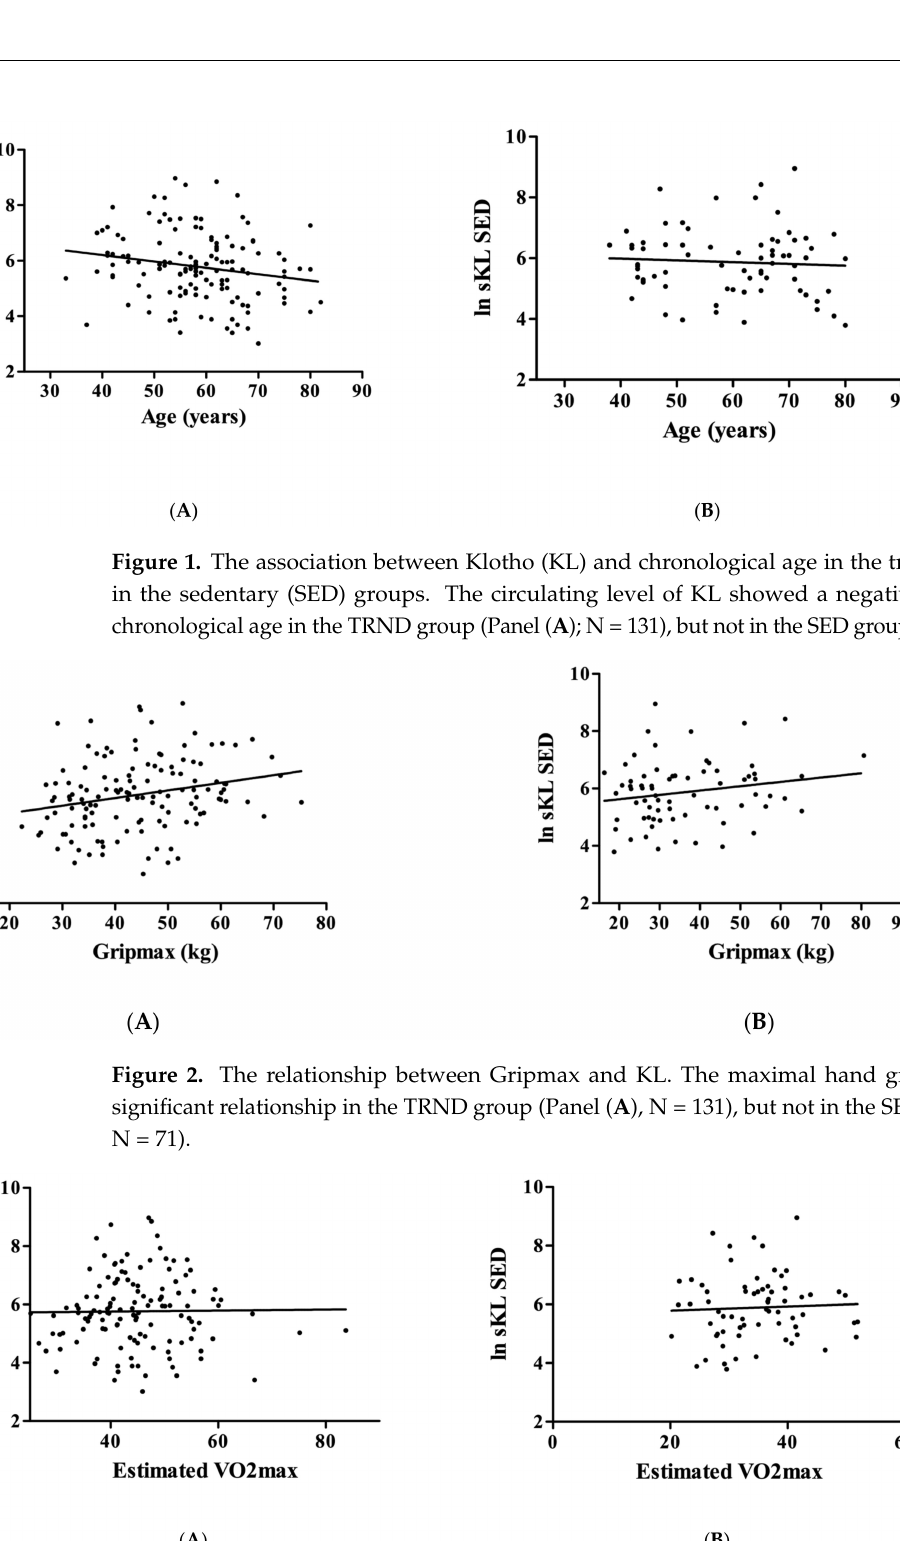
Figure 3. The relationship between estimated VO2max and KL. The maximal oxygen uptake was estimated, and no significant relationship was found in the TRND group (Panel ( A ), N = 131) and the SED group (Panel ( B ), N =